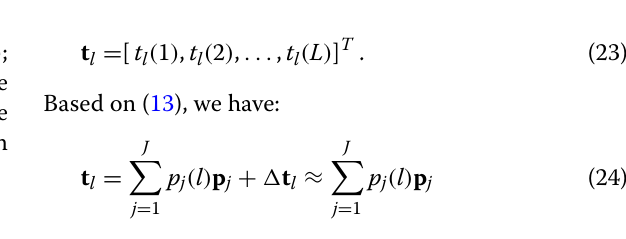
(cid:6) (cid:6) r − 1 r − 1 (η) = (η) ; t l p l j = 1 j = 1 j j